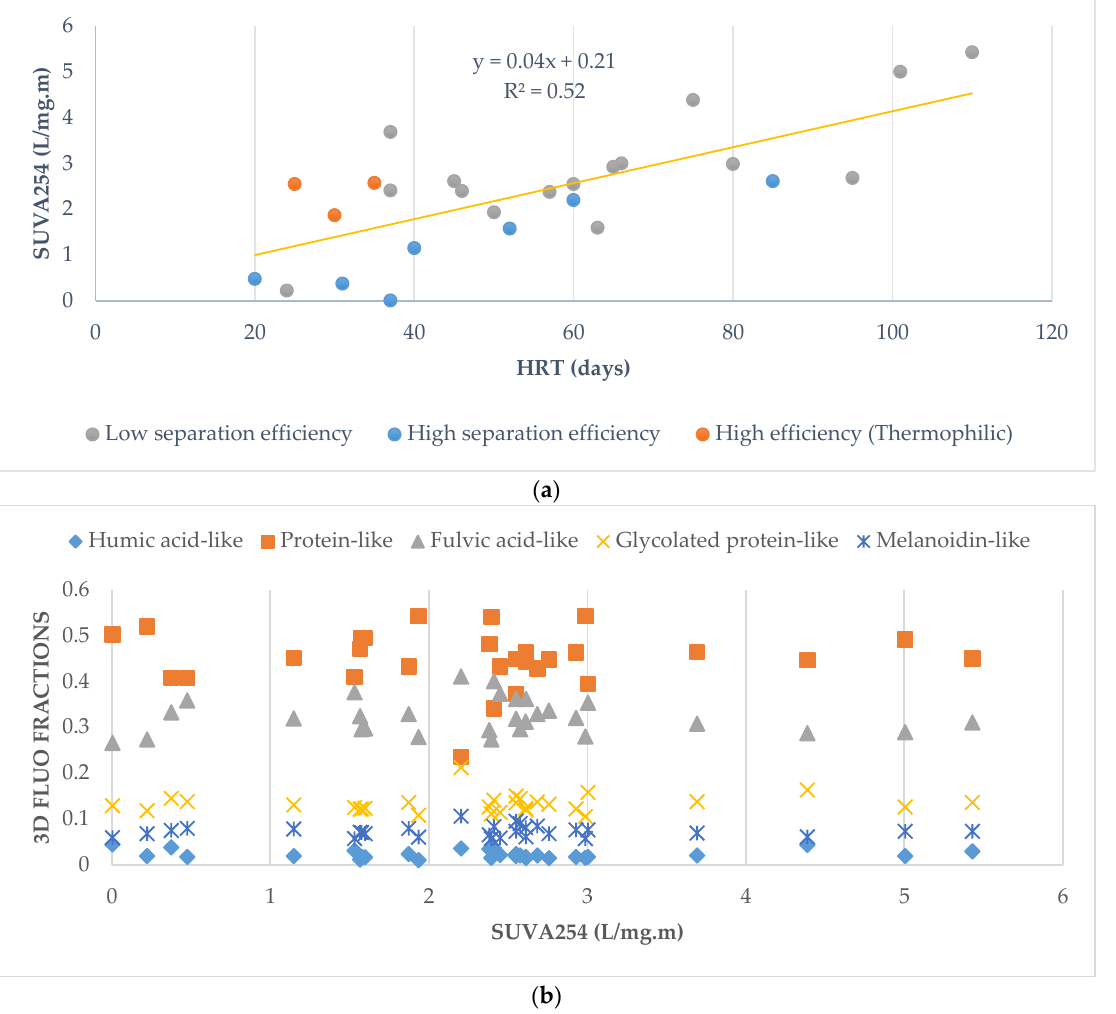
Figure 6. ( a ) SUVA 254 (L/mg·m) in the liquid fraction vs HRT (days) and ( b ) 3D fluorescence spectrum zones vs SUVA 254 (L/mg·m).